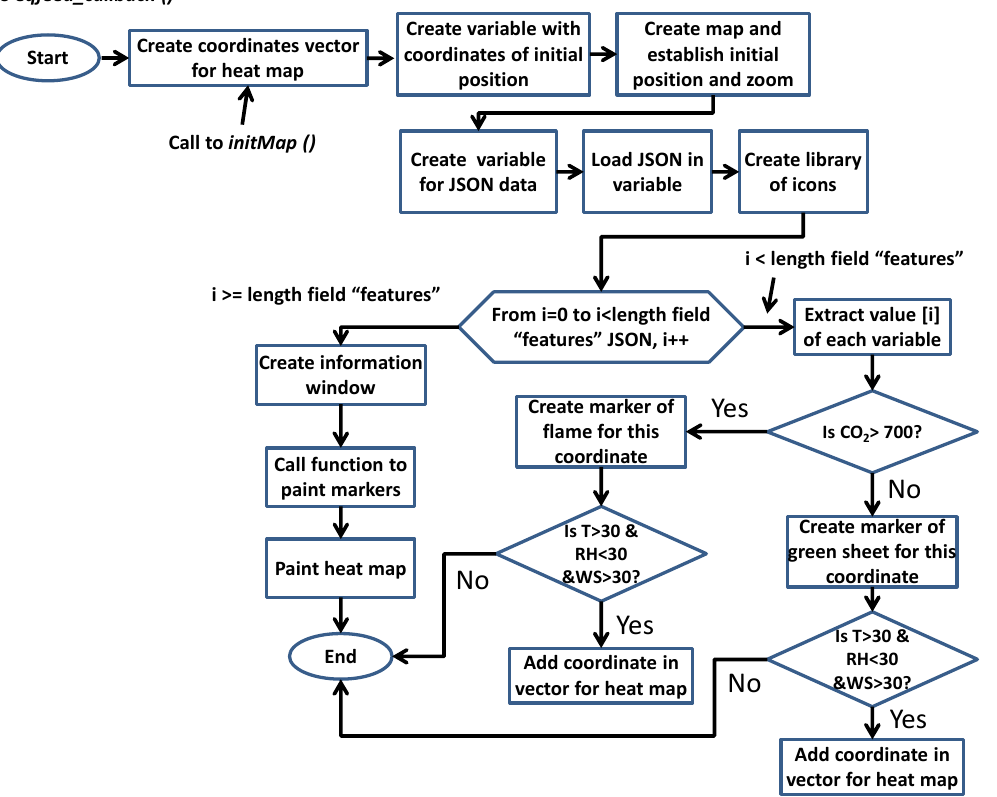
Figure 12. Workflow diagram of our system.